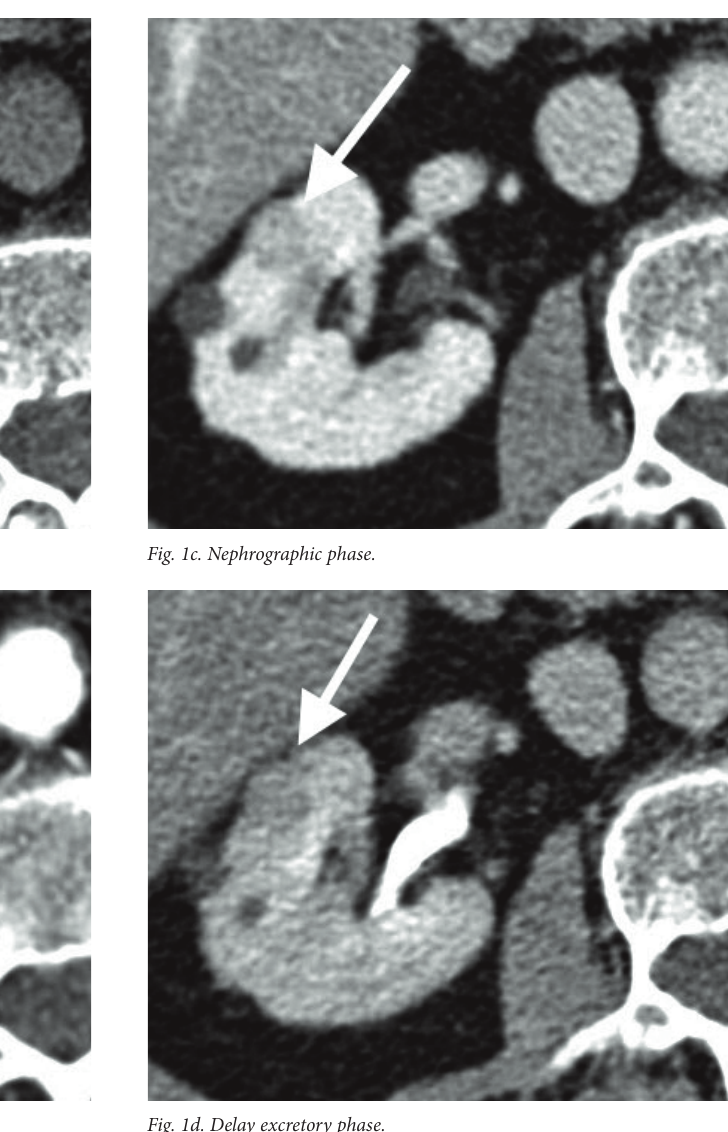
Fig. 1b. Arterial